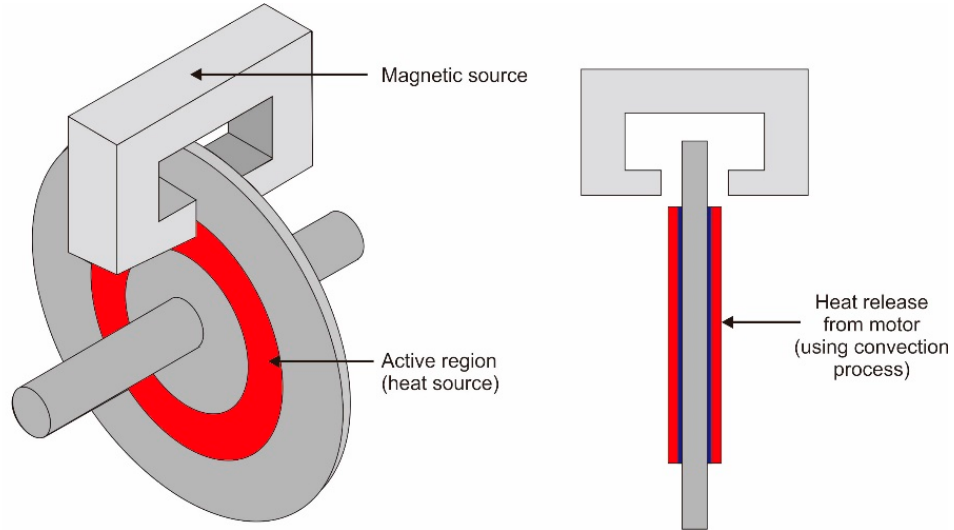
Figure 1. ECB design used in the modeling process.